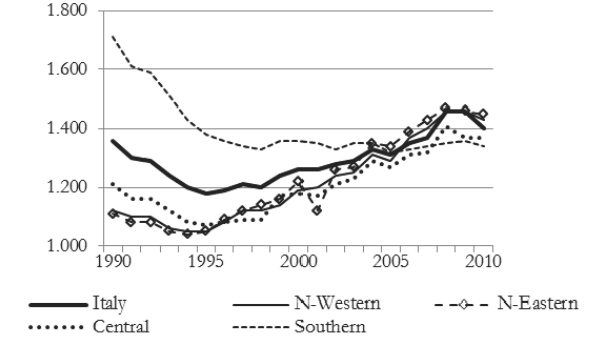
Figure 1 – Total fertility rate in Italian regions,